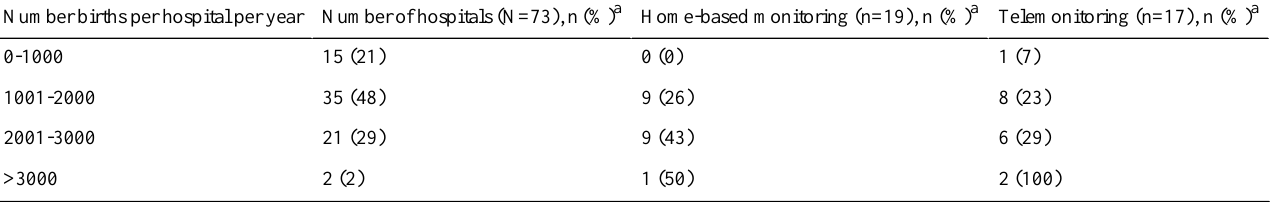
Table 1. Number of hospitals offering home-based monitoring and telemonitoring for high-risk pregnancies in 2018 in relation to the number of births per hospital per